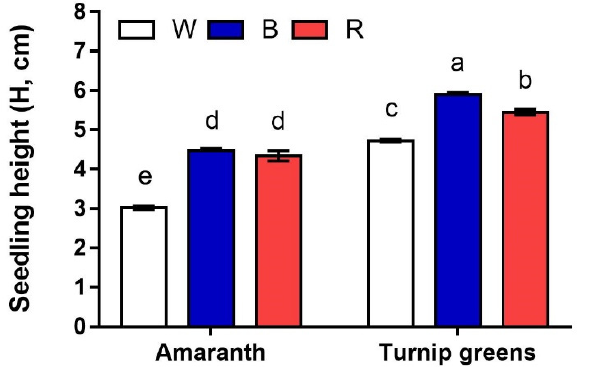
Values (mean ± se ) within each column, followed by the same letter, do not significantly differ at p ≤ 0.05 according to Tukey’s test; ns = not significant; significant at p ≤ 0.01 (**) and 0.001 (***). Three biological replicates were used for measurements ( n = 3). However, light exerted a different effect, depending on species ( S × L , p ≤ 0.01). In amaranth, seedlings were almost 3 cm tall in W, whilst their height exceeded 4 cm in B S × L ** ns ns and R. In turnip greens, blue light (B) promoted plant growth, resulting in a final seedling height close to 6 cm; in this species, white light (W) adversely affected plant growth, leading to a final height < 5 cm (Figure 1).